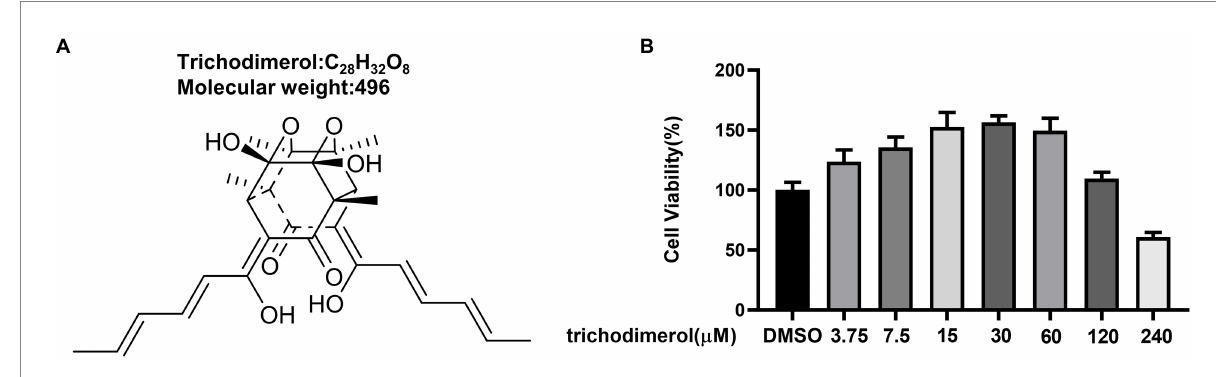
FIGURE 1 The structure and cytotoxicity of trichodimerol. (A) The structure of trichodimerol. (B) Cell viability. Cell viability was tested with CCK8 reagent 48 h after RAW264.7 macrophages were administered different amounts of trichodimerol, and dimethyl sulfoxide (DMSO) was used as a blank